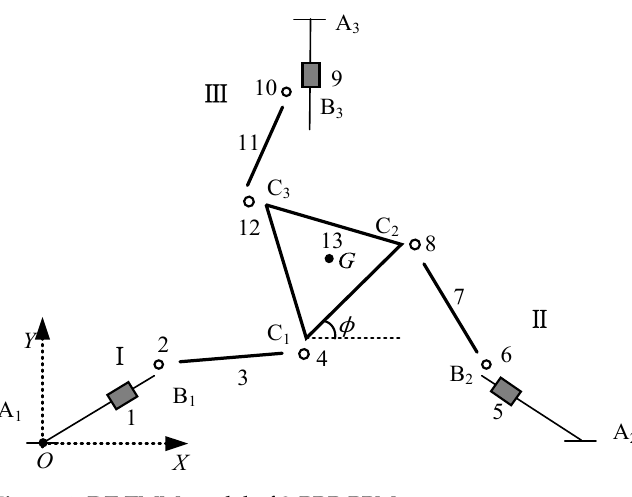
Figure 4. DT-TMM model of 3-PRR PPM.